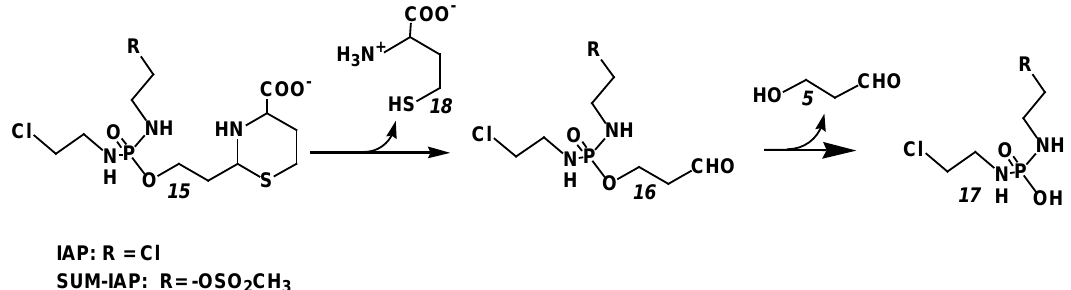
Figure 5. Hydrolysis of I-aldophosphamide (IAP) (R = Cl) and SUM-IAP (R = –OSO 2 CH 3 ( 15 )) to I-aldophosphamide ( 16 ) and homocysteine ( 18 ) and the formation of I-phosporeamidemustard ( 17 ) and 3-hydroxypropanal ( 5 ).